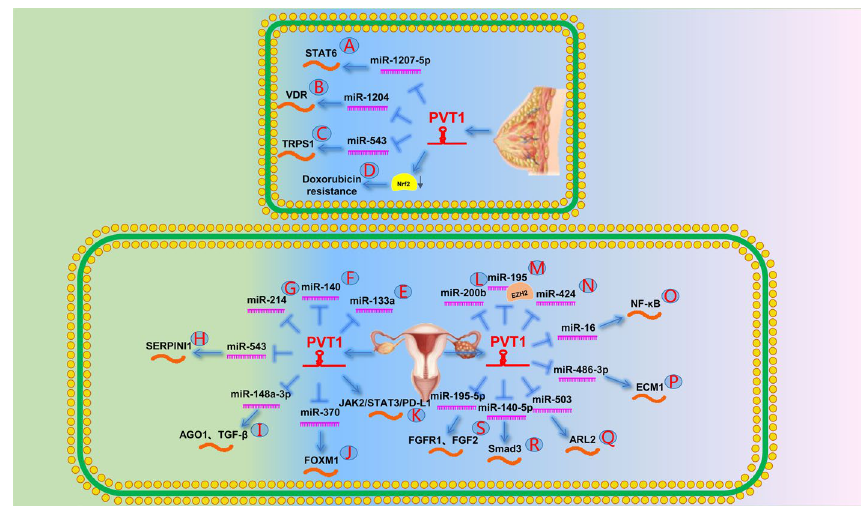
Fig. 5 The role of PVT1 in the endocrine reproductive system. A PVT1 downregulates STAT6 by generating miR-1207-5p. B PVT1 targets VDR by generating miR-1204. C PVT1 promotes the expression of TRPS1 by targeting miR-543. D PVT1 caused Nrf2 degradation, eventually leading to doxorubicin resistance in TNBC. E PVT1 directly targets miR-133a. F PVT1 directly targets miR-140. G PVT1 directly targets miR-214. H PVT1 promotes SERPINI1 expression by targeting miR-543. I PVT1 upregulates AGO1 by targeting miR-148a-3p to promote the expression of TGF-β and ultimately leads to cisplatin resistance in OC. J PVT1 promotes FOXM1 expression by targeting miR-370. K PVT1 promotes OC cisplatin resistance by affecting the JAK2/STAT3/ PD-L1 signaling pathway. L PVT1 directly targets miR-200b. M PVT1 directly targets miR-195. N PVT1 directly targets miR-424. O PVT1 promotes NF-κB signaling by targeting miR-16. P PVT1 promotes ECM1 expression by targeting miR-486-3p. Q PVT1 promotes ARL2 expression by targeting miR-503. R PVT1 promotes Smad3 expression by targeting miR-140-5p. S PVT1 promotes the expression of FGF2 and FGFR1 by targeting